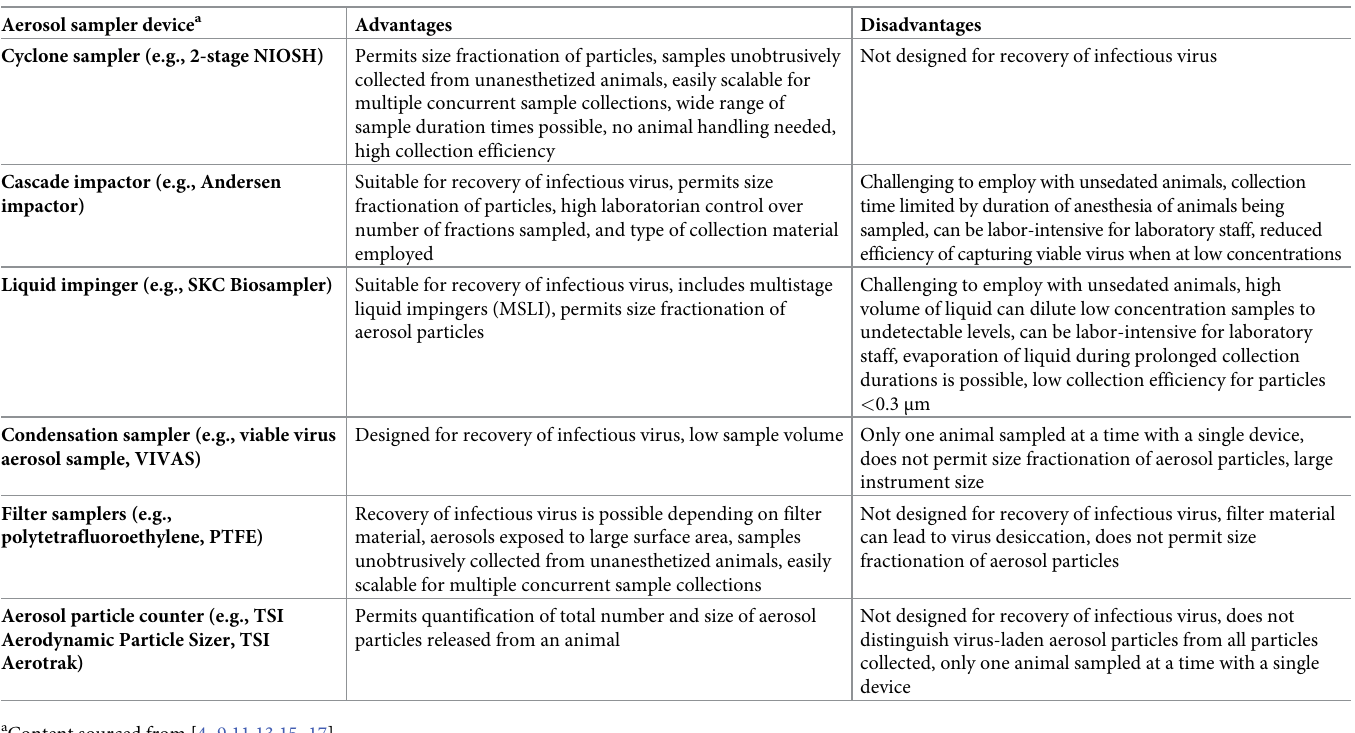
Table 1. Laboratory approaches to sample aerosols released from virus-infected